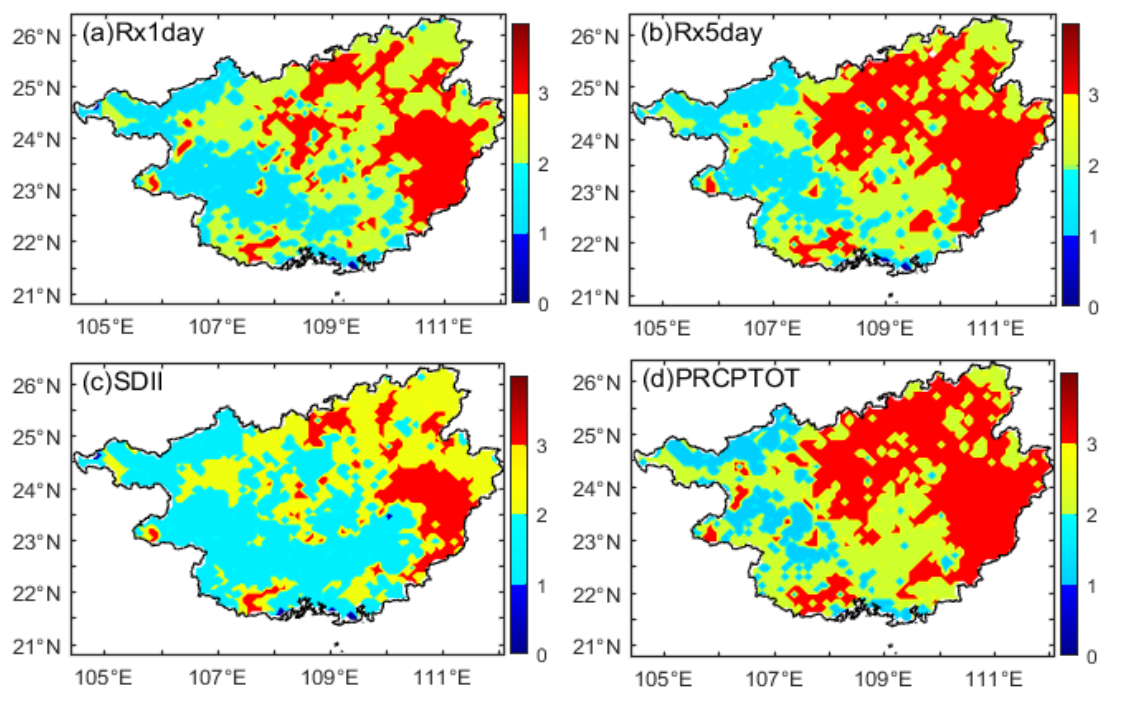
Figure 8. Spatial distributions of the time-lagged response of the NDVI to the precipitation extremes: ( a ) Rx1day; ( b ) Rx5day; ( c ) SDII; and ( d ) PRCPTOT. Note: ‘0’ NDVI and extreme climate indices were collected over the same period; ‘1–3’ NDVI lagged the extreme indices by 1–3 months. This study conducted four correlation analyses (namely, no lag, 1 month, 2 months, and 3 months), and then superimposed the results of the four times to take the maximum value.